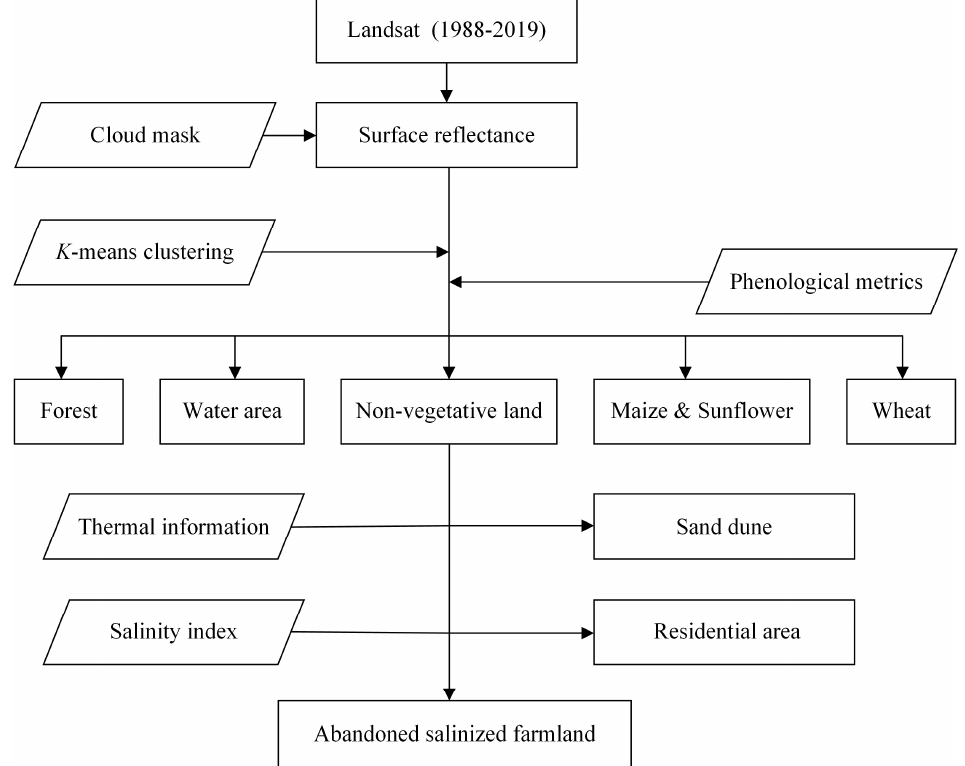
Figure 2. Methodological workflow.